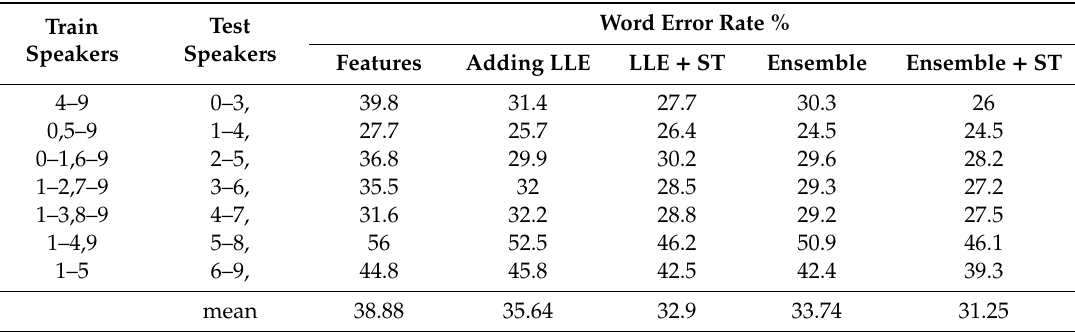
Table 8. Word Error Rate for 40% data as